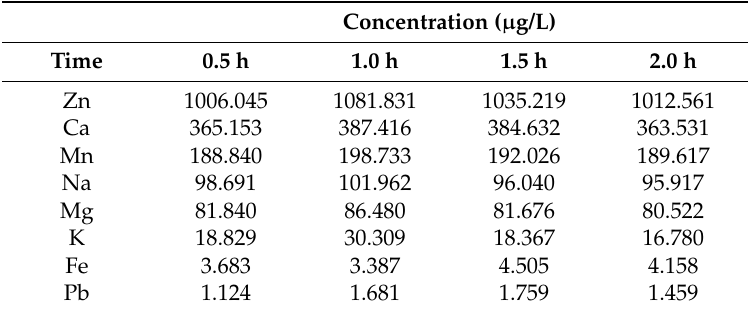
Table 4. Concentrations ( µ g/L) of different elements in systems A.